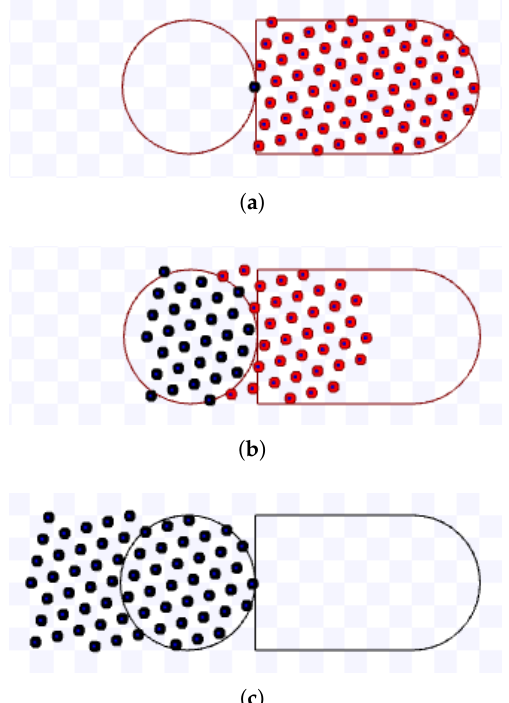
Figure 27. Simulation on Stage for hexagonal packing strategy using s = 3 m, θ = π / 12 during T = 10 s. Available on https://youtu.be/Wji8XlSQJBQ, accessed on 12 June 2022. ( a ) 0 s: beginning of the simulation; ( b ) After 5 s; ( c ) 10 s: ending of the